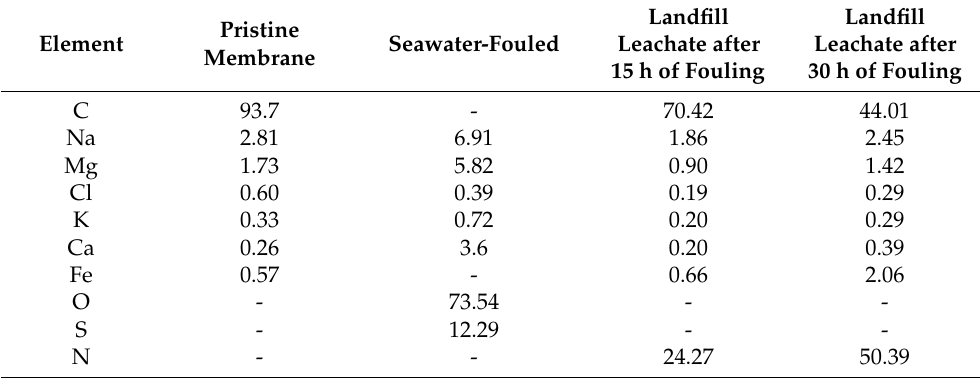
Table 3. Elemental composition (wt%) of pristine and fouled membranes by seawater and landfill